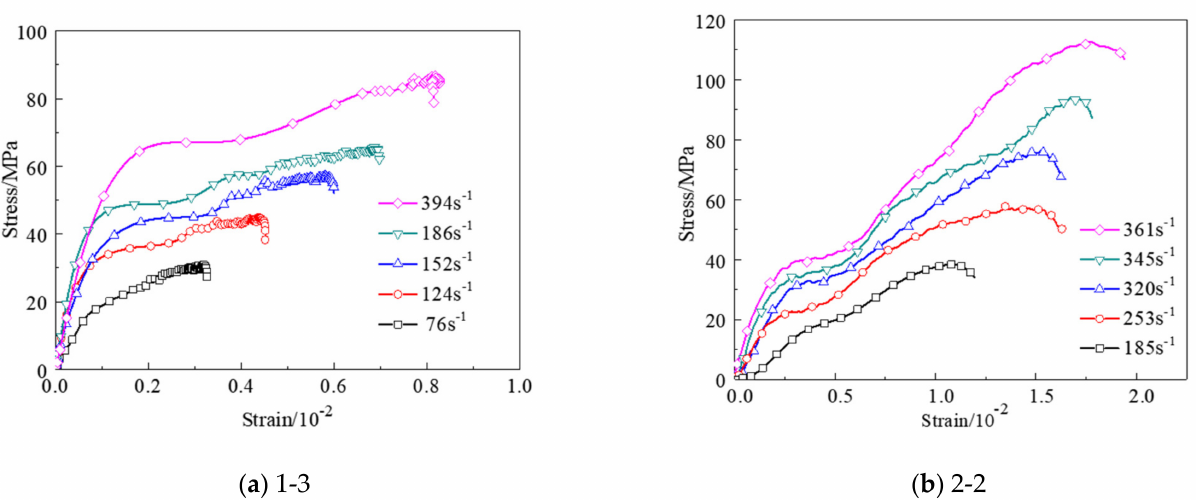
Figure 5. Original waveform of the sample under impact loading. ( a ) Original waveform without the waveform shaper; ( b ) Original waveform with waveform shaper.